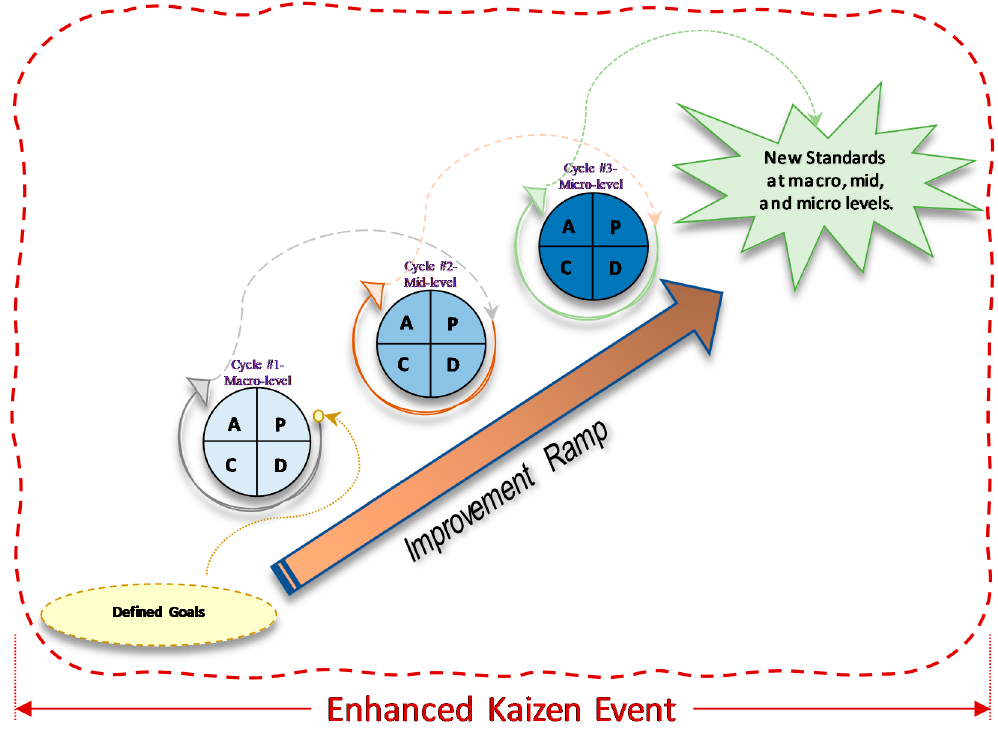
Figure 1. Enhanced Kaizen Event: a single KE with sequential PDCA Cycles within the KE.